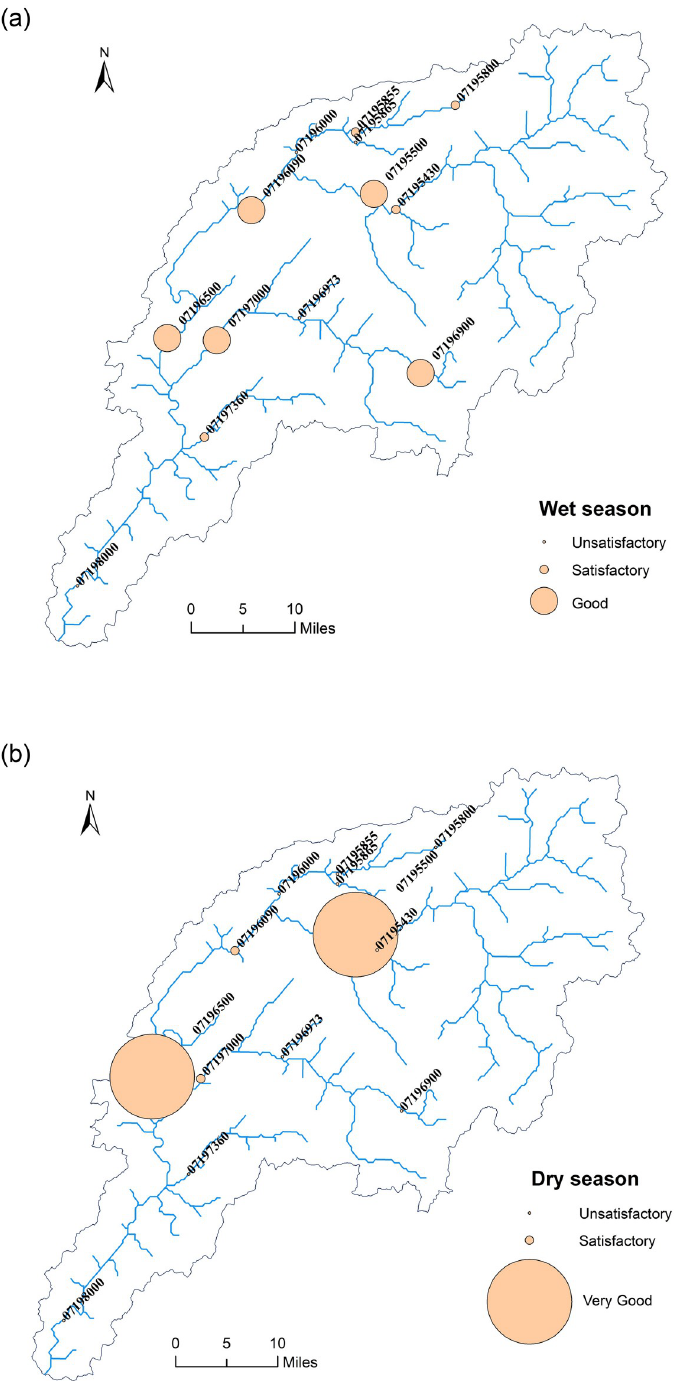
Fig 8. SWAT-SVR model performance ratings during the (a) wet and (b) dry season.